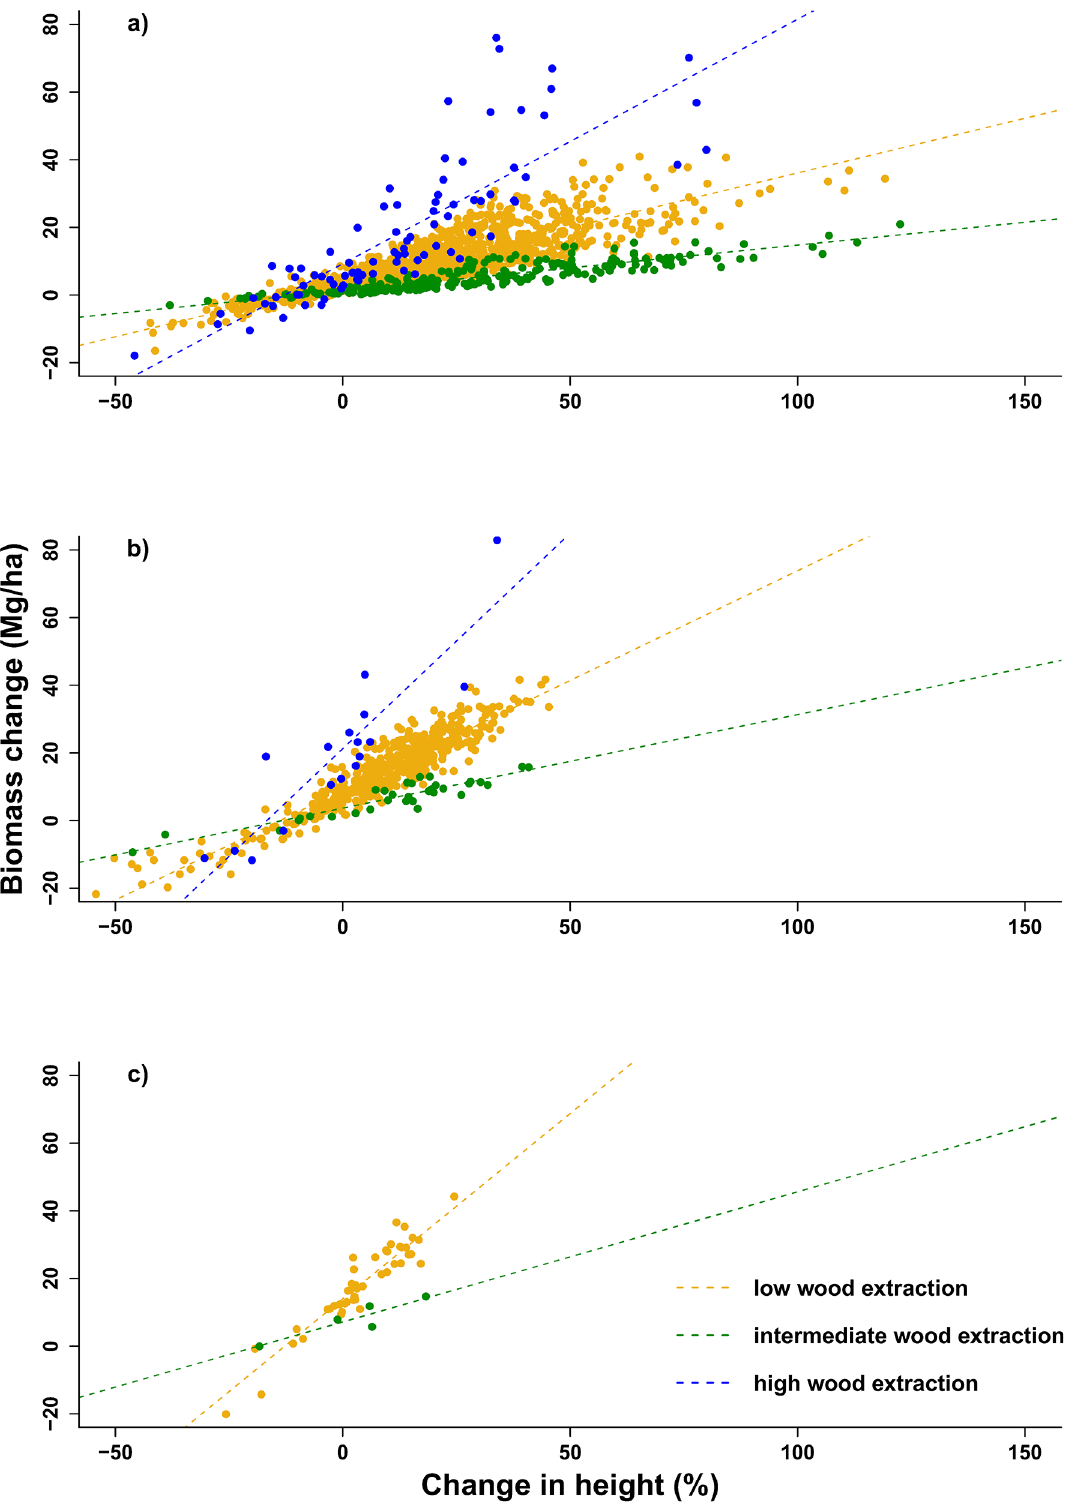
Fig 2. Height-specific biomass change as a function of relative height change per grid cell. Height categories are a) 1 – 3 m, b) 3 – 5 m and c) 5 – 10 m for rangelands of high, intermediate and low wood extraction pressure. There were no data for the 5 – 10 m height class in the high wood extraction rangeland and the > 10 m height class for all rangelands as there were no grid cells with an average height over 10 m. Grid cell size: 25 m x 25 m.